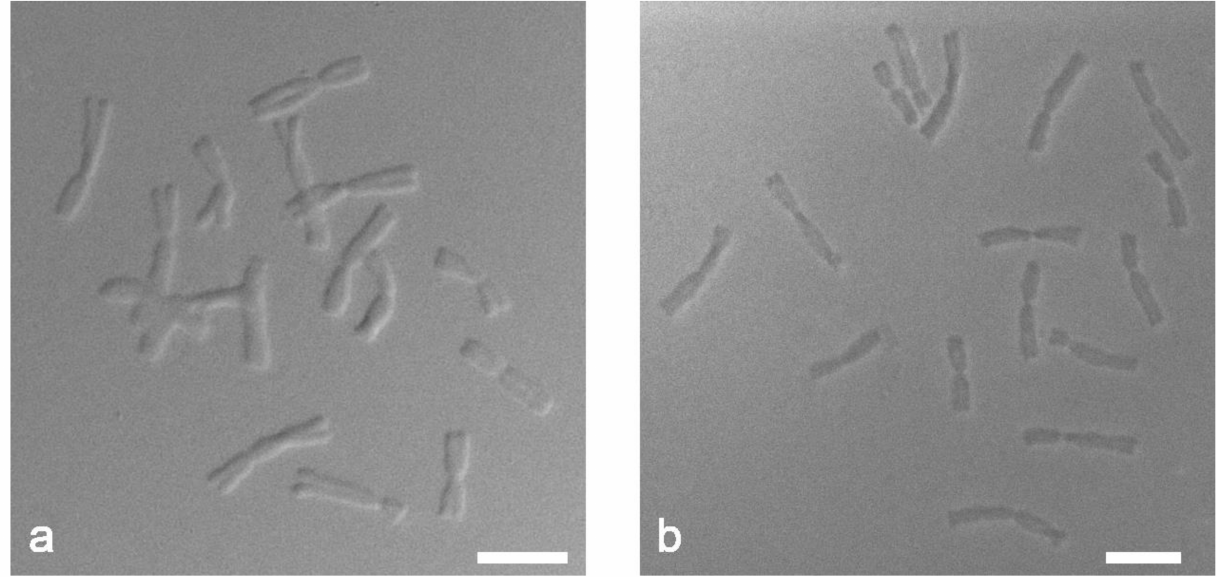
Figure 3. Differential interference contrast (DIC) microscopy of mitotic metaphase chromosomes of Allium cepa : ( a ) “SteamDrop” method of chromosome slide preparation; ( b ) squashed method of chromosome slide preparation. Scale bar—10 µ